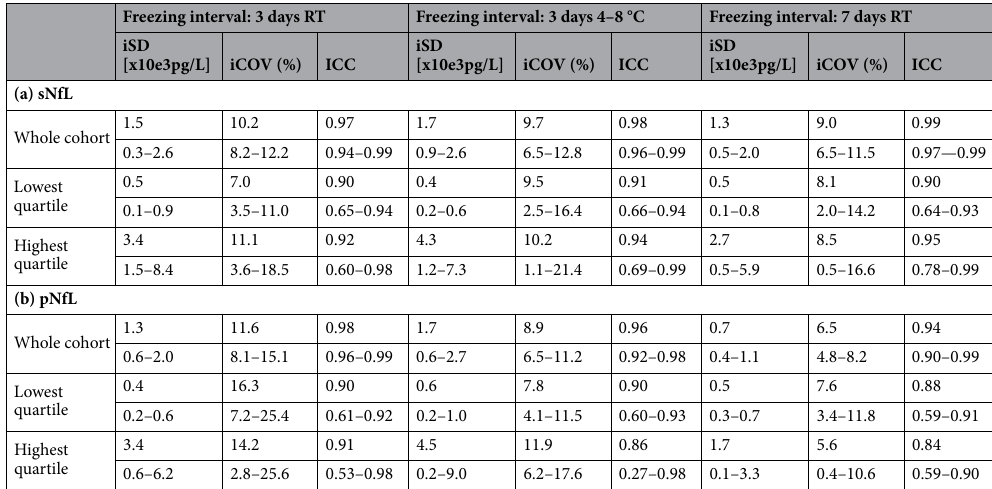
Table 3. Reliability of NfL concentrations at different freezing intervals compared to immediate freezing. Mean values and 95% confidence intervals for (a) serum neurofilament light chain (sNfL) and (b) plasma neurofilament light chain (pNfL). ICC intraclass correlation coefficient, iCOV intraindividual coefficient of variance, iSD intraindividual standard deviation, pNfL plasma neurofilament light chain, RT room temperature, sNfL serum neurofilament light